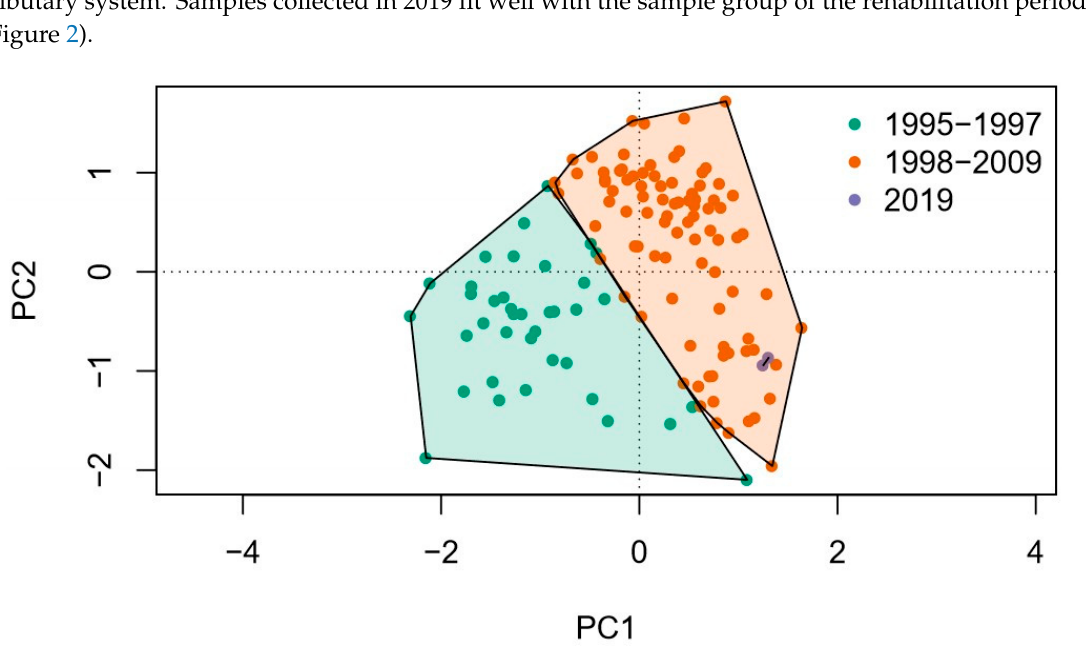
Figure 3. Plot of principal component analyses of deployed reed and natural reed samples from points a4 and a6 in the Ásvány branch system. Different colors denote sampling periods.